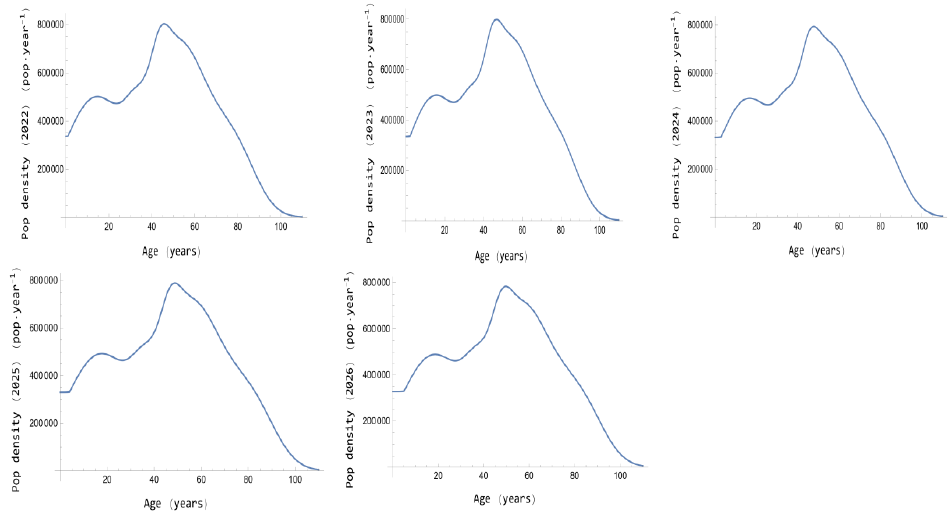
Figure 5. Population densities versus age forecasted in Spain for the 2022–2026 period.